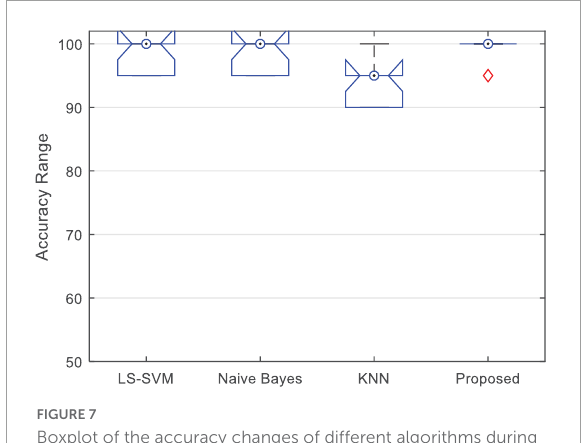
FIGURE7 Boxplot of the accuracy changes of different algorithms during 10-fold of